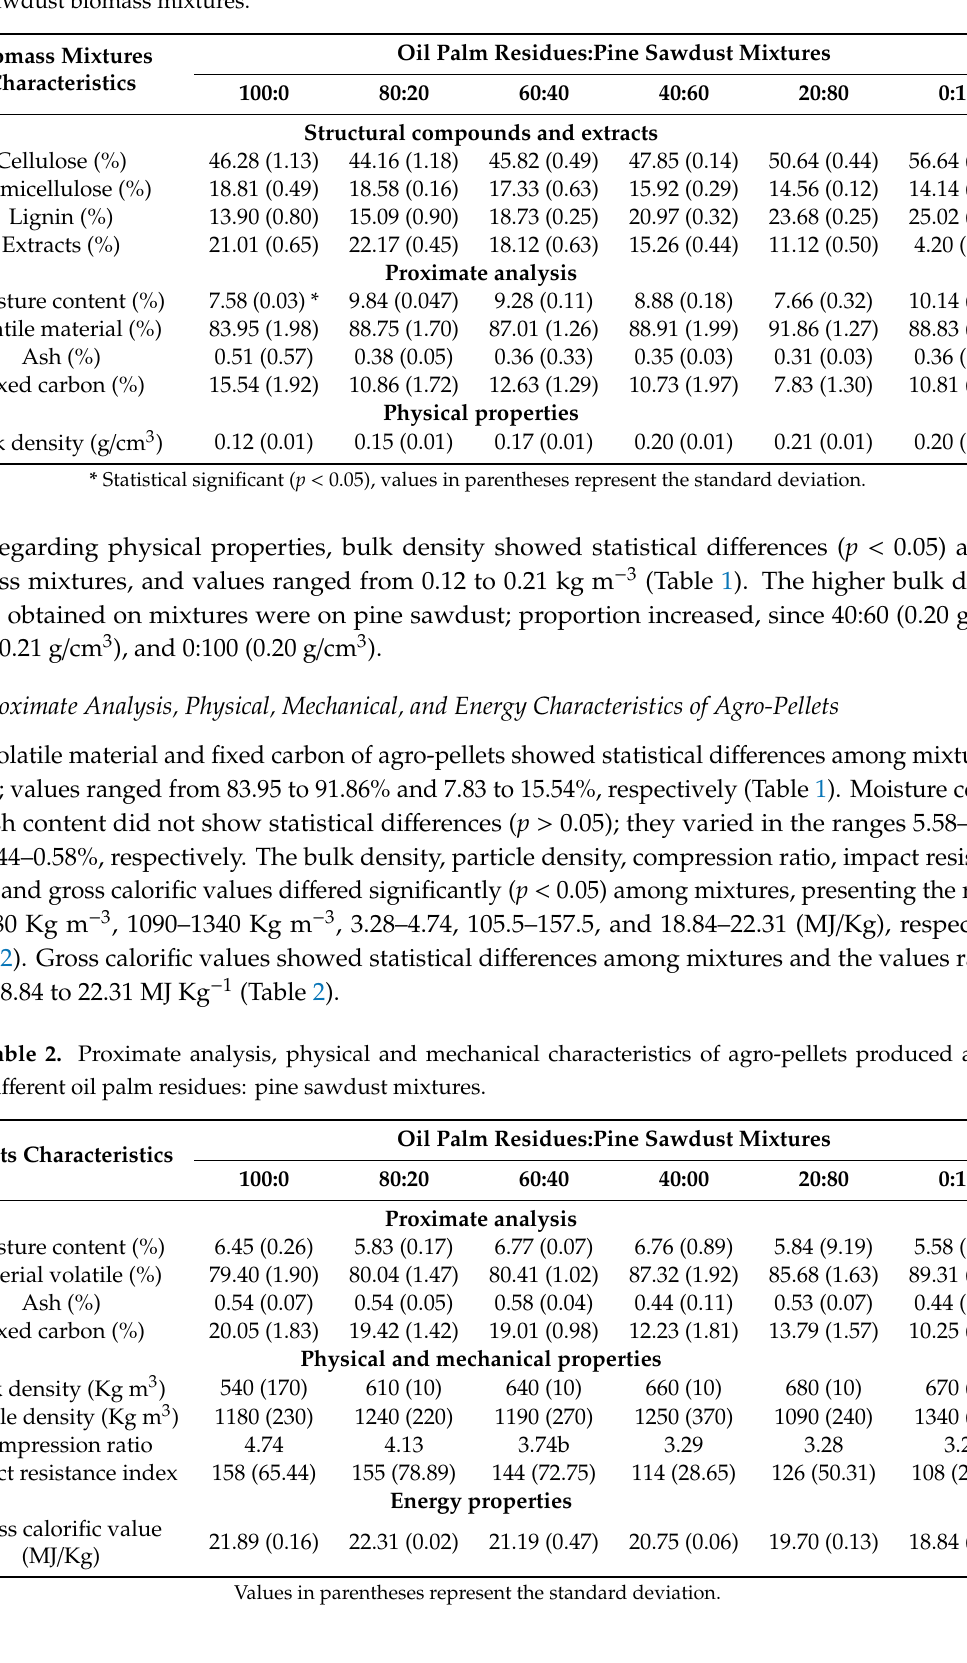
Table 1. Chemical characteristics, proximate analysis, and bulk density of oil palm residues:pine sawdust biomass mixtures.